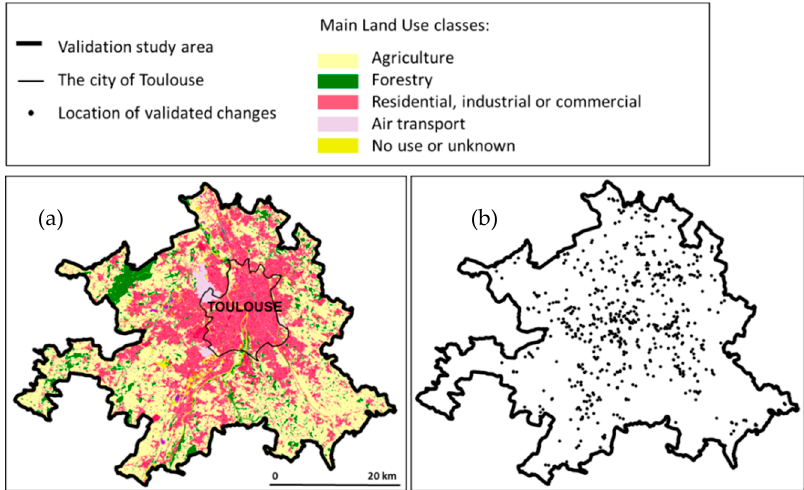
Figure 6. Location of the validation areas showing ( a ) the main authoritative Land Use (LU) classes ( © IGN) and ( b ) the spatial distribution of the validated changes.